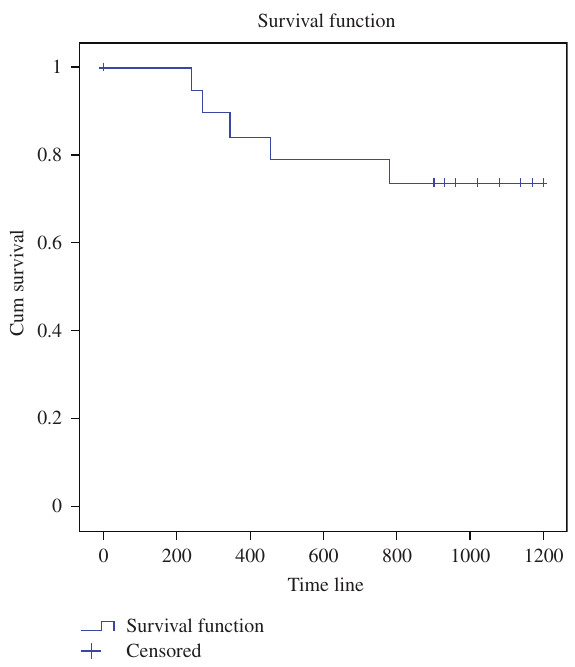
FIGURE 4: Updated OS in 19 patients receiving Imatinib for steroid-refractory cGVHD (Olivieri et al.